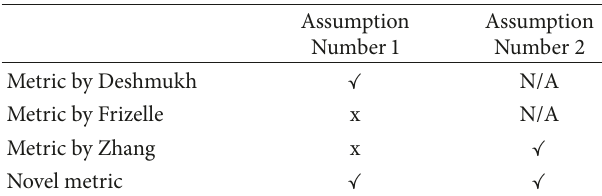
Table 15: Comparison of complexity indicators according to the specified